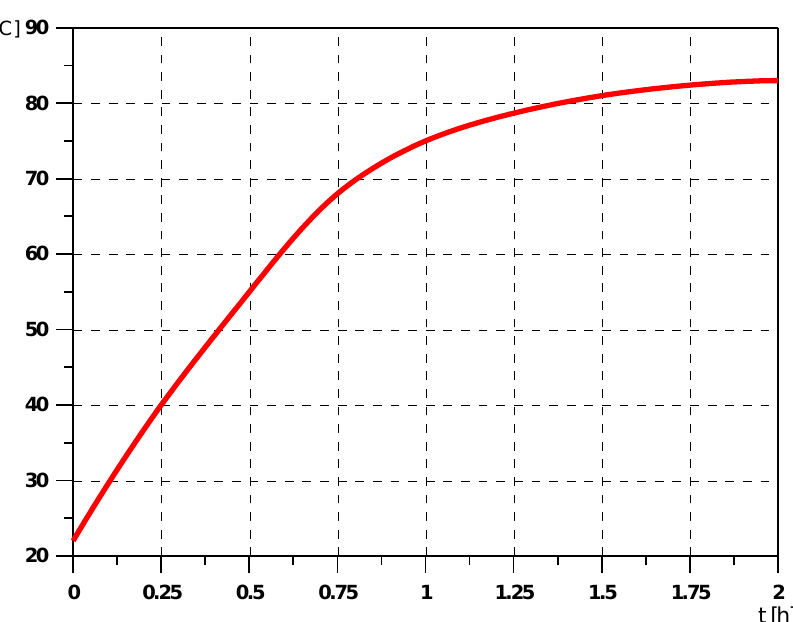
Figure 8. Damper temperature changes as a function of time: filled with a liquid with a viscosity of 30,000 cSt.